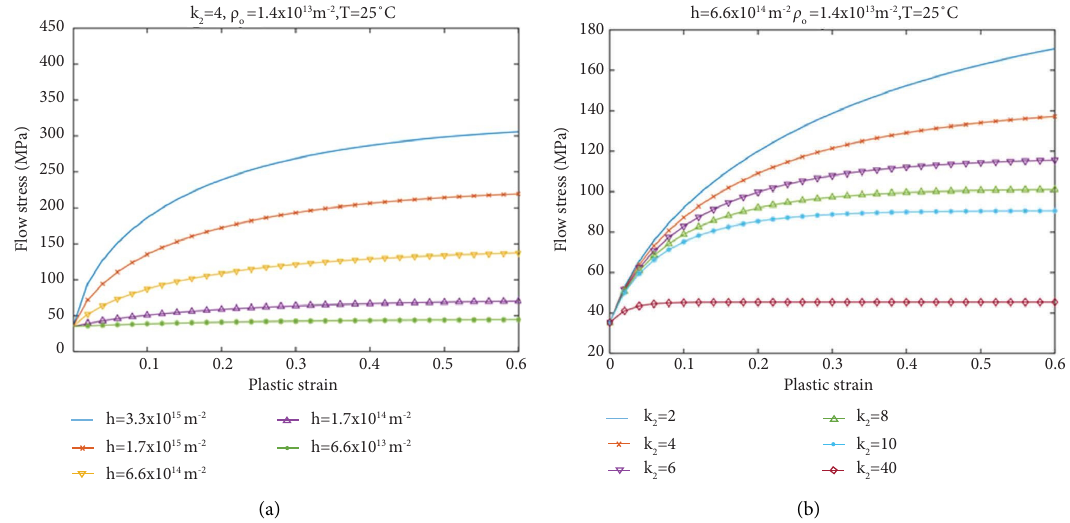
Figure 5: Te efects of parameters (a) h and (b) k